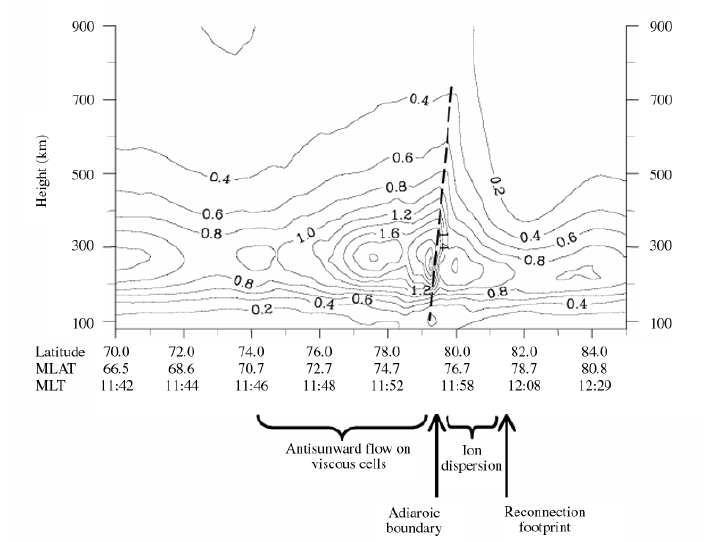
Fig. 16. Tomographic image showing signatures in the high-latitude ionosphere of reconnection at the magne- tospheric lobe. From Pryse et al. (1999), reproduced by permission of the American Geophysical